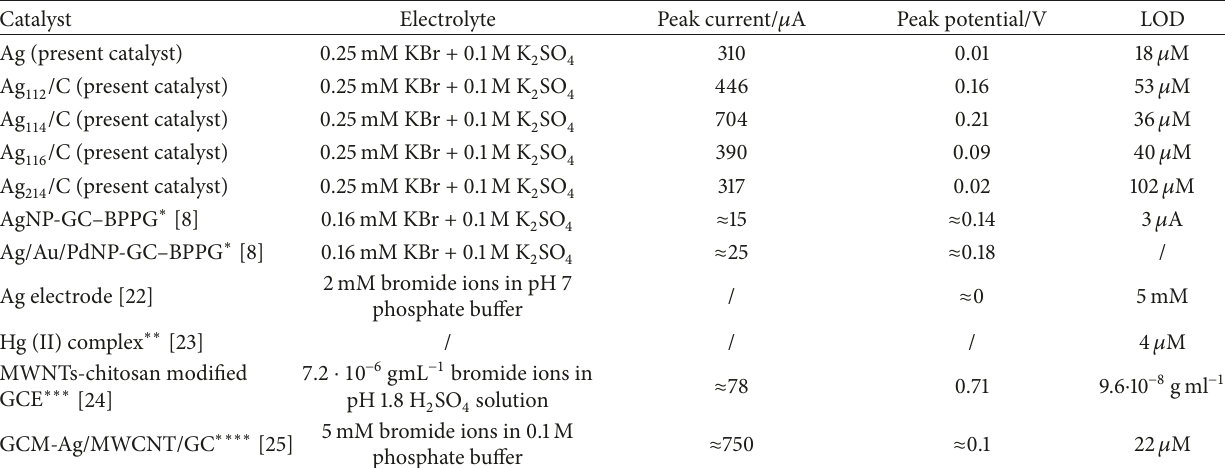
Table 3: Comparison of performance of different electrodes for bromide sensing.